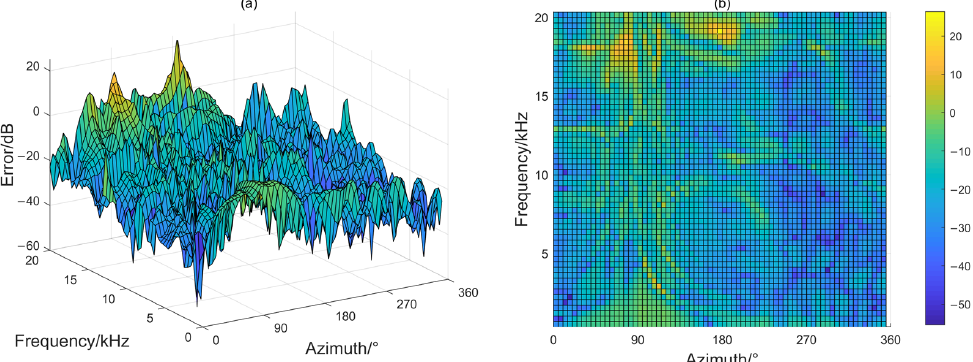
Figure 2. Mean relative reconstruction error across all distances on the horizontal plane (left ear): ( a ) three-dimensional surface image; ( b ) color-scale